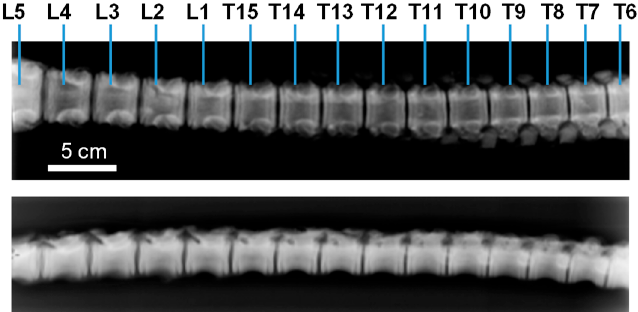
Figure 1. Radiographies showing the frontal (above) and lateral (below) views of the thoracic (T) and lumbar (L) parts of the spine of the growing-finishing pig model used in the study, with the different motion segments considered in the biomechanical testing.